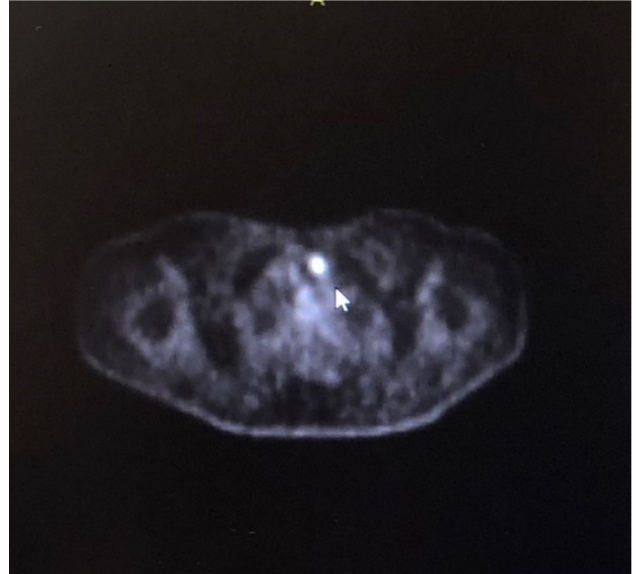
Figure 2. Focal increased F-18 fluorodeoxyglucose uptake was detected in left lobe of thyroid gland on positron emission